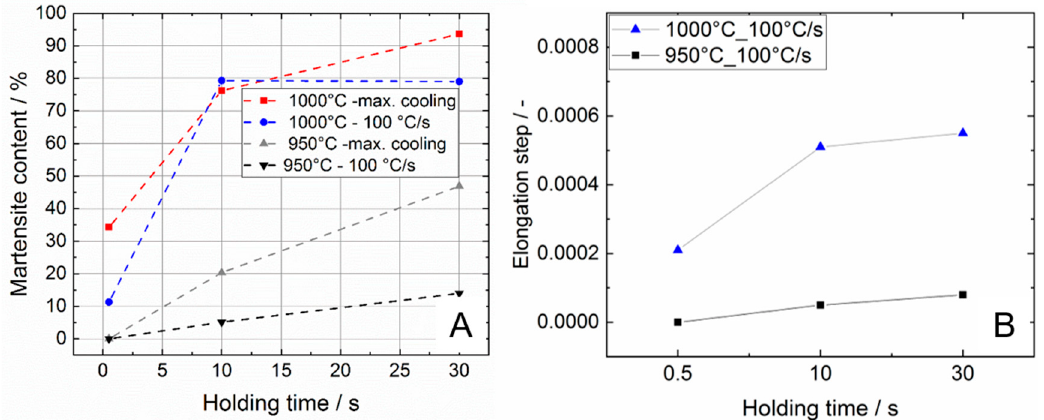
Figure 10. Comparison between martensite vs. holding time distribution ( A ) and elongation step vs. holding time distribution ( B ) for maximum control temperatures of 950 and 1000 °C.